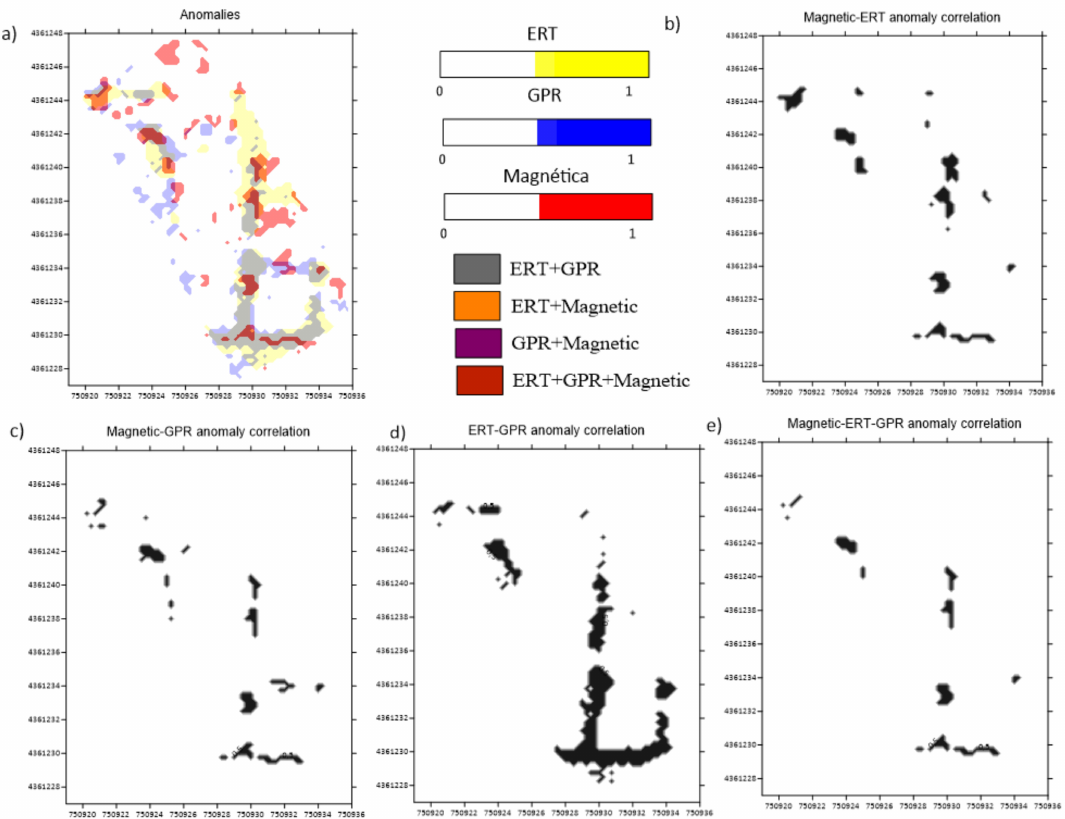
Figure 13. ( a ) Selection of the anomalies corresponding to walls from the magnetic method, ERT and GPR. ( b – e ) Spatial correlations (value 1: black, value 0: white) for the results obtained from the ( b ) magnetic and ERT methods; ( c ) the magnetic and GPR methods; ( d ) the ERT and GPR methods; and ( e ) the magnetic, ERT and GPR